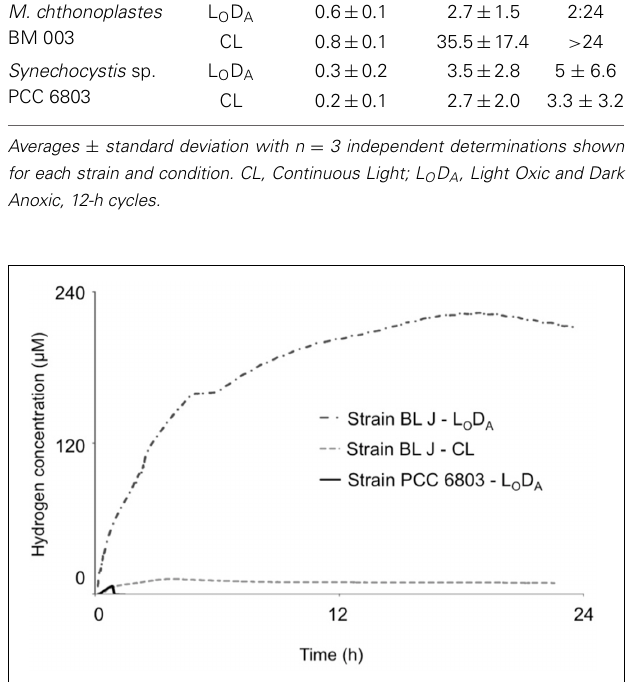
FIGURE 2 | Comparison of the dynamics of fermentative hydrogen production in continuous light (CL) grown L. aestuarii BL J, along